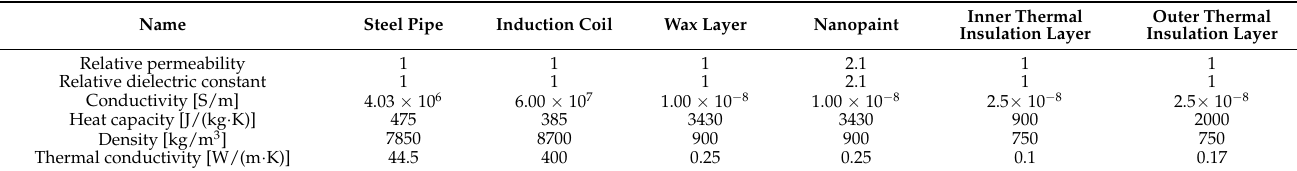
Table 2. Physical properties of relevant materials in the numerical simulation.